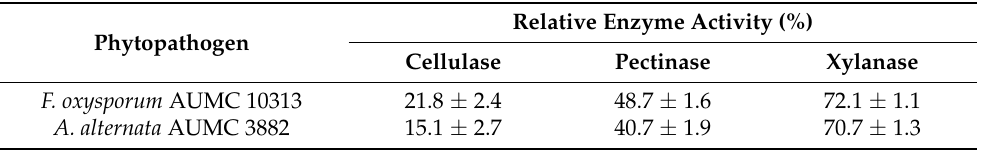
Table 1. Impact of the biogenic TeNPs produced by Gayadomonas sp. TNPM15 on the plant cell wall-degrading enzymes of F. oxysporum AUMC 10313 and A. alternata AUMC